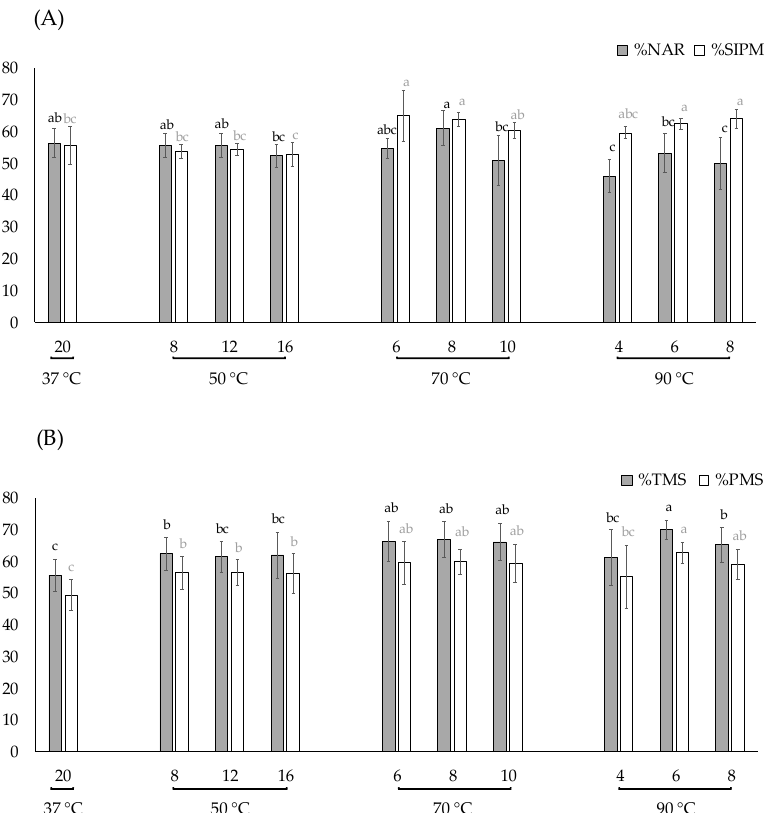
Figure 4. Evaluation of different thawing conditions. Data are expressed as mean ± standard deviation. ( A ) Effect on normal acrosomal ridge (%NAR) and sperm with intact plasma membrane (%SIPM); a, b, c Indicate significant differences between treatments ( p < 0.05); black letters are within %NAR and grey letters within %SIPM. ( B ) Effect on total motile sperm (%TMS) and progressive motility sperm (%PMS); a, b, c Indicate significant differences between treatments ( p < 0.05); black letters are within %TMS and grey letters within %PMS.